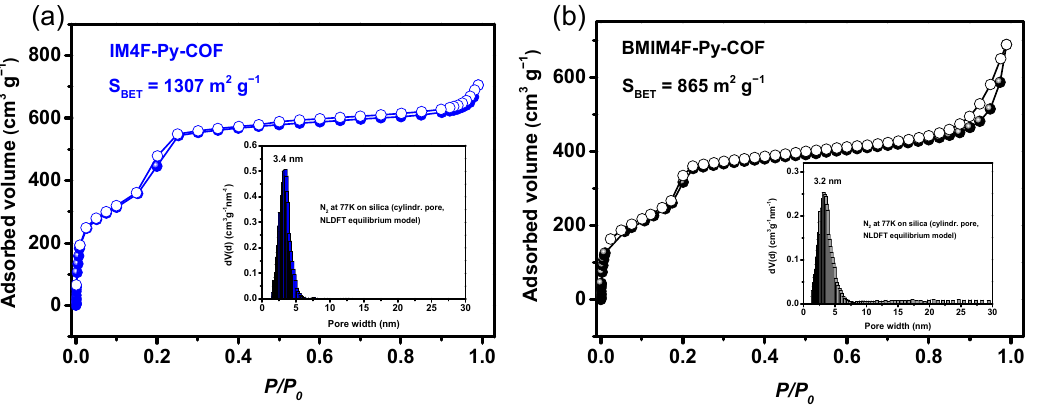
Figure 3. N 2 sorption isotherms and pore size distribution (insert) of IM4F-Py-COF ( a ) and BMIM4F-Py-COF ( b ).